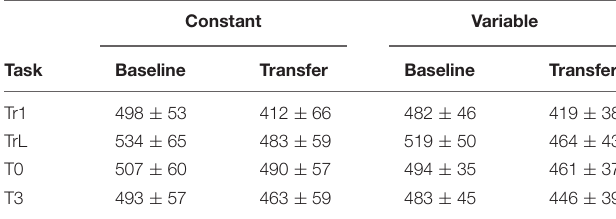
FIGURE 3 | Performance during training. In both groups RTs decreased linearly during training. Error bars represent standard error of the mean. Note that in the Variable group, blocks of Tr1 and Tr2 training were interleaved.